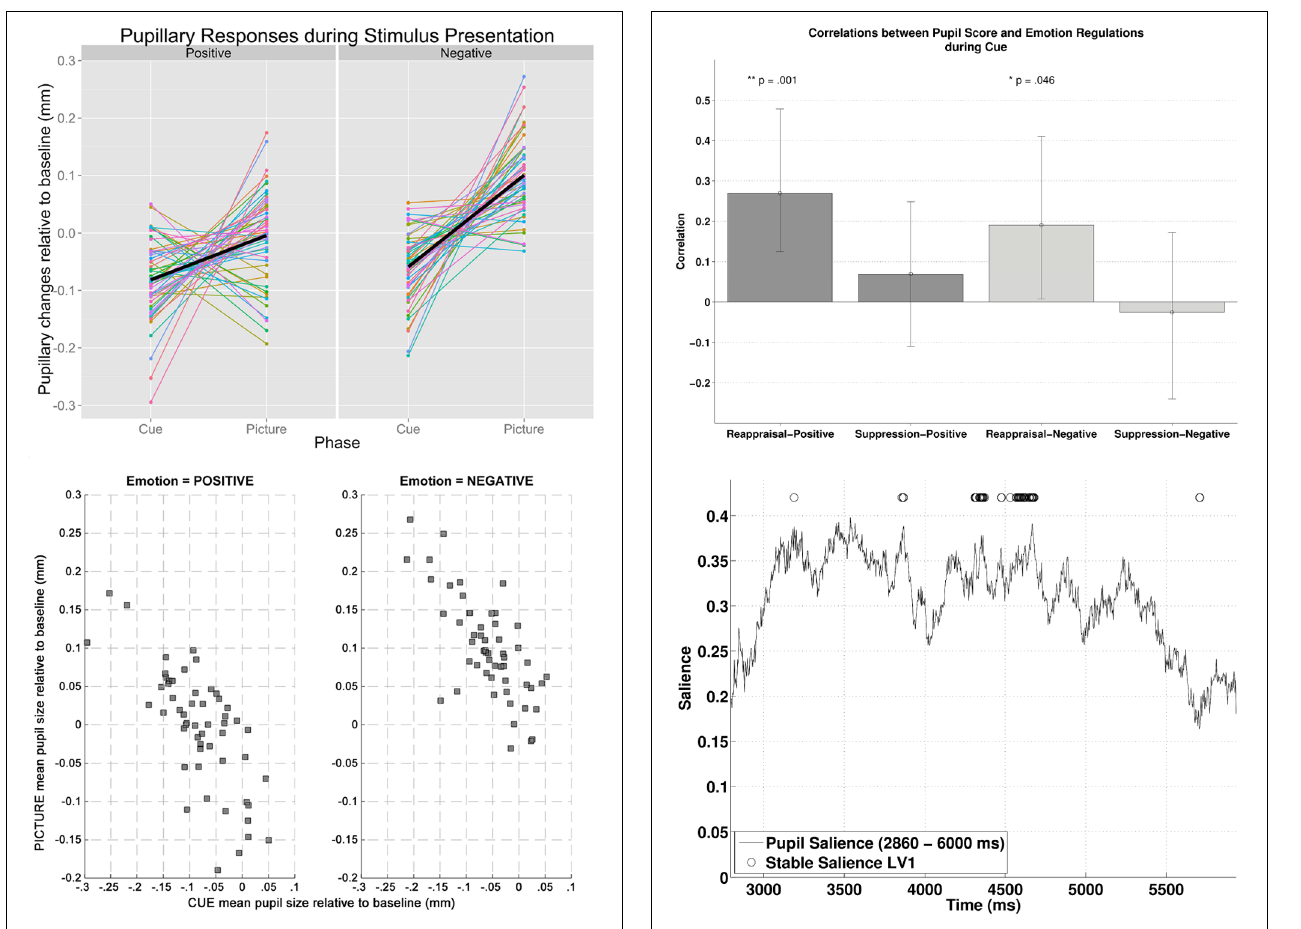
FIGURE 3 | The upper panel shows the correlations between participants’ pupillary responses and the ERQ scores in Latent Variable 1 during cue presentation. Error bars represent boot-strapped 95% confidence intervals. The lower panel shows that the saliences are in general positive, implying that the reappraisal correlations are interpreted as: the higher the rating, the larger the pupillary responses (or alternatively, a tendency from constriction to